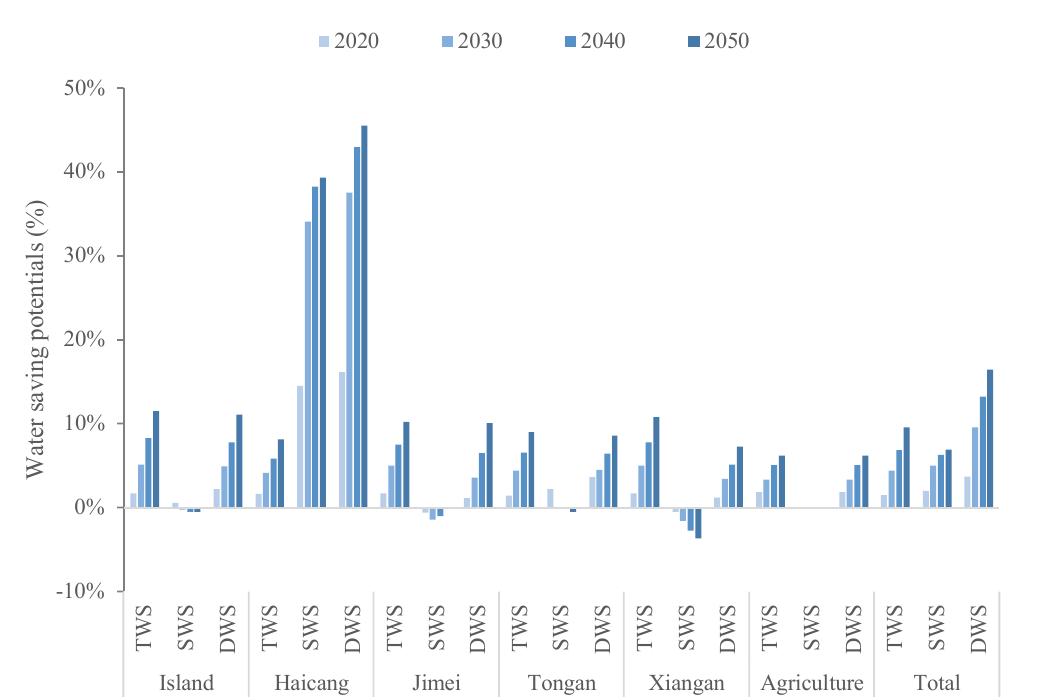
Figure 4. Water saving potential of each district and the agricultural sector under the three water saving scenarios. Note: PLS is the acronym for planning scenario; TWS is the acronym for technical water-saving scenario; SWS is the acronym for structural water-saving scenario; DWS is the acronym for double water-saving scenario.